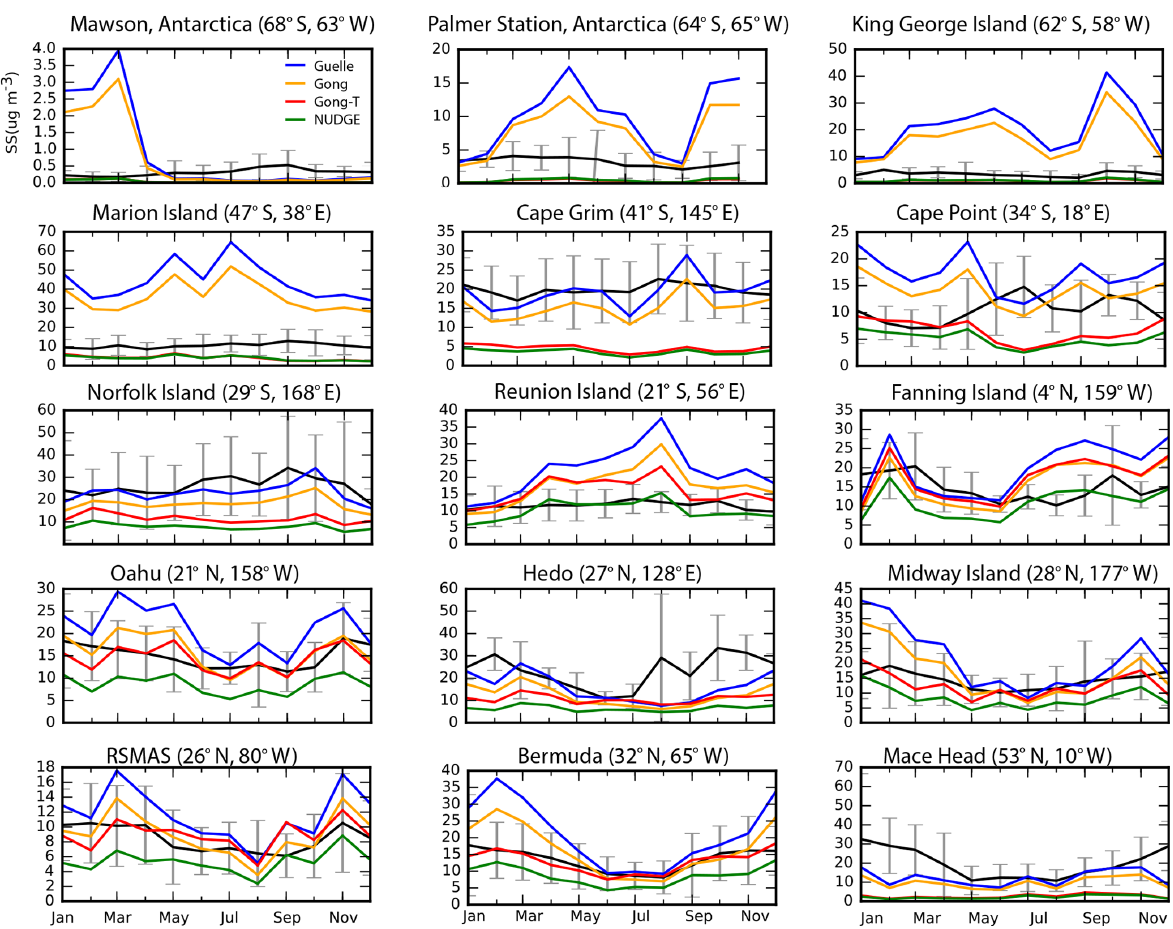
Figure 24. Time series of observed versus simulated monthly mean sea salt aerosol surface concentrations for the year 2010 spatially collocated at the AEROCE stations shown in Fig. 17. Only stations where the sea salt concentrations remain below 100µm − 3 are considered to exclude stations with clearly local impact.